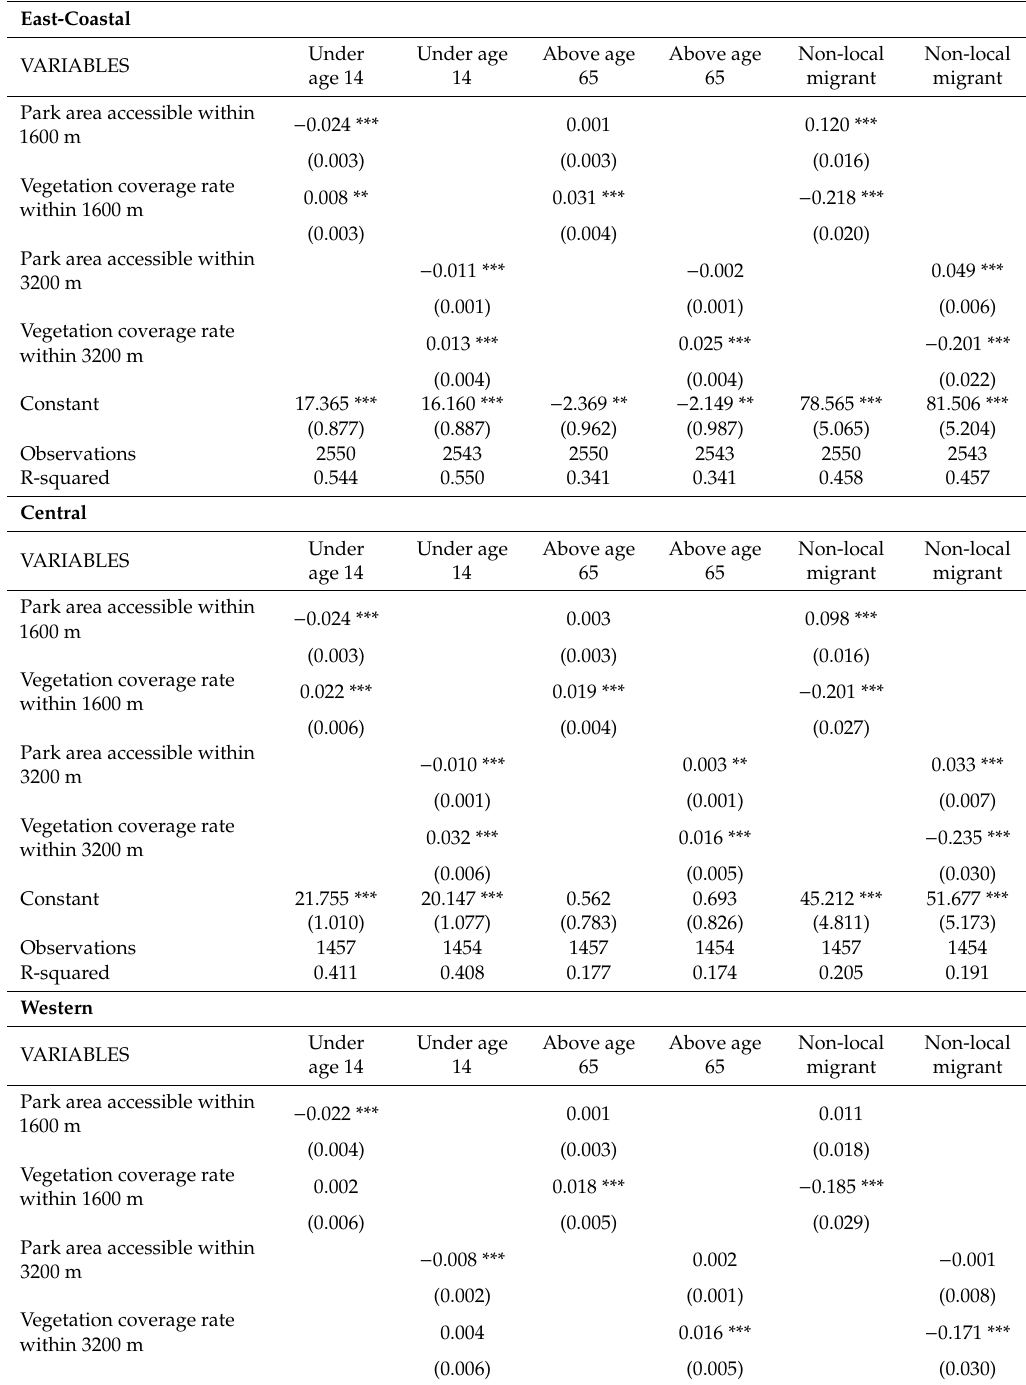
Table 3. Regional